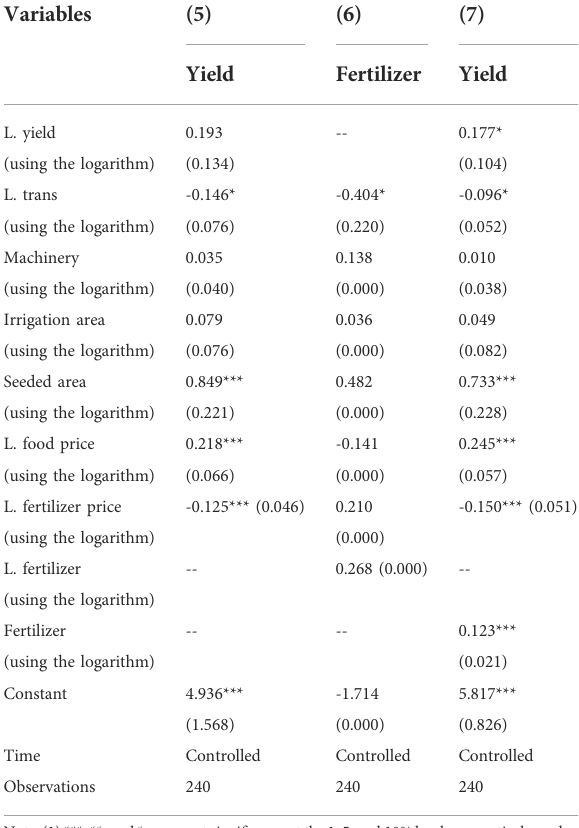
TABLE 6 Results of the mediation effect of chemical fertilizer application on